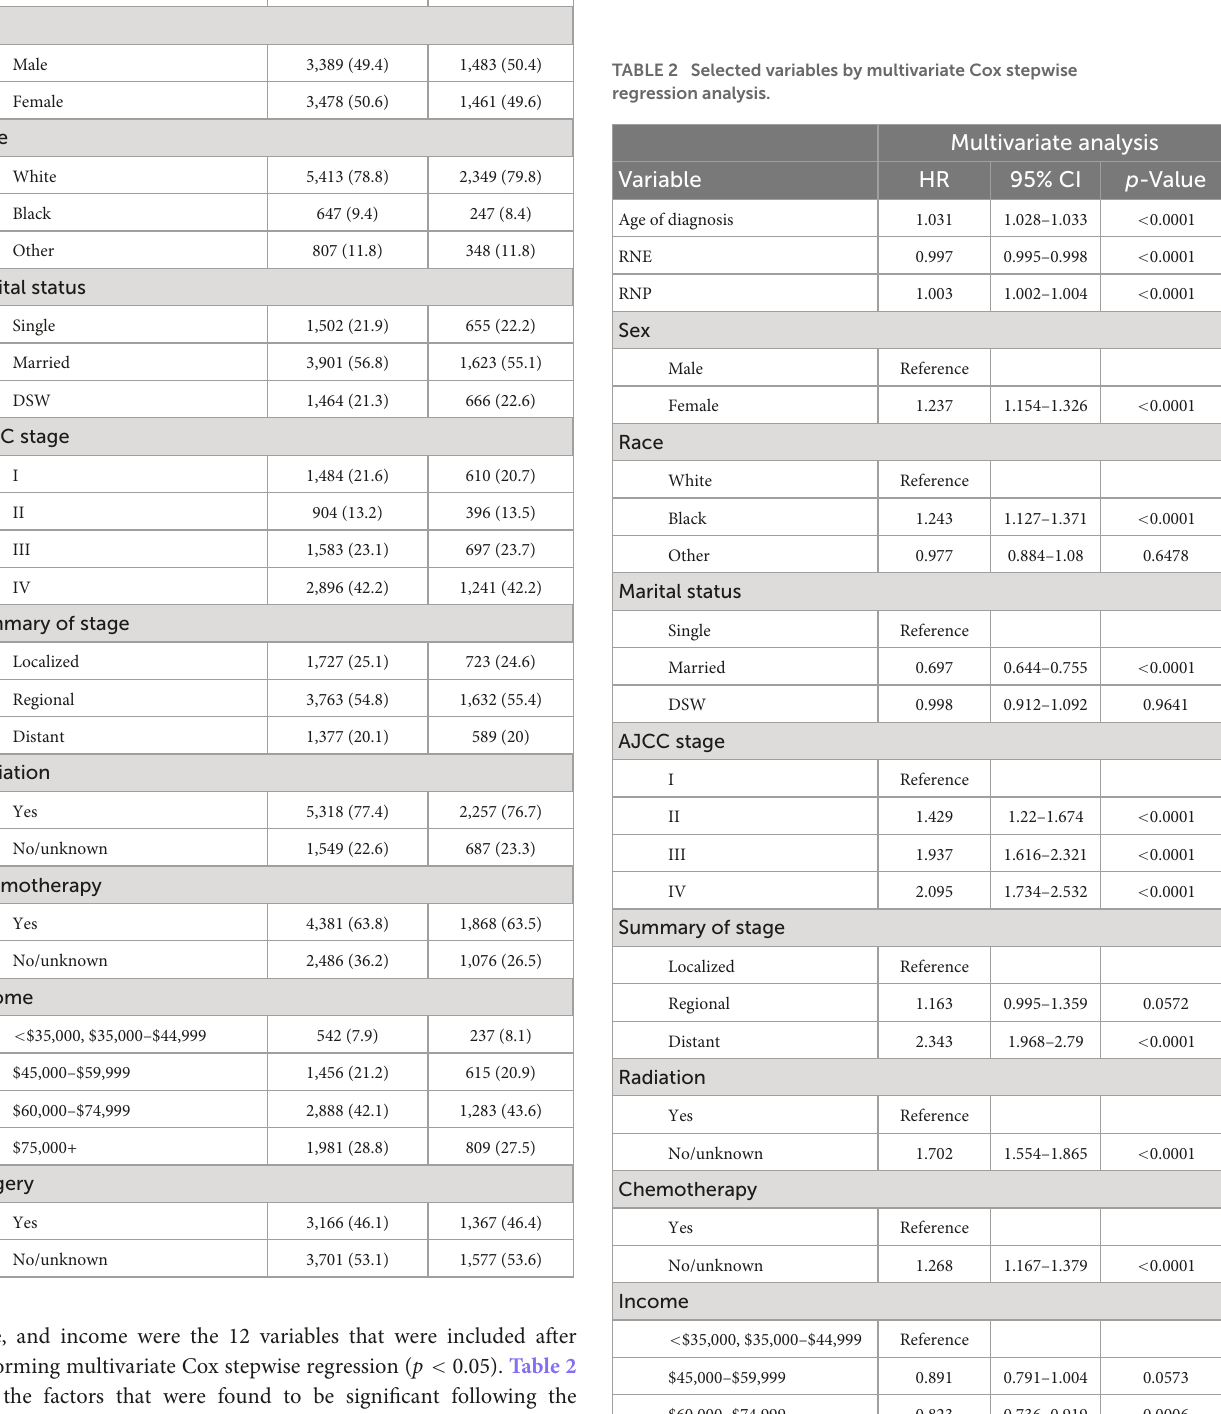
TABLE 2 Selected variables by multivariate Cox stepwise regression analysis.